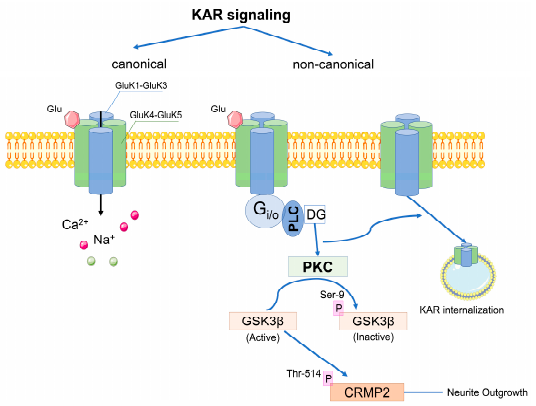
Figure 1. Canonical and non-canonical signaling of KARs (adapted from refs. [4,20] ). Postsynaptic kainate receptors are involved in synaptic transmission by mediating a small current with slow activation and deactivation kinetics. In the hippocampus, when activated by kainate or glutamate, KARs control neuronal excitability through the inhibi- tion of hyperpolarization currents, resulting in a marked increase in the firing frequency of the CA1 pyramidal cell action potentials. This activity proceeds by coupling KARs to G i/o and PKC proteins, indicating an additional metabotropic mechanism of action [5]. Kainate receptors also have the potential to affect the autoregulation of their mem- brane expression through activity-dependent internalization triggered by PKC phosphor- ylation. Furthermore, KARs are involved in the regulation of neurite growth in DG neu- rons, while the GluK2 subunit, through coexistence in a functional complex with the neu- ronal cotransporter KCC2, has an important role in the structural maturation of dendritic spines [4,32]. One of the suggested mechanisms involved in the metabotropic KAR pathway is re- lated to the NMDAR-independent regulation of LTP in the CA1-CA3 synapses. Kainate- dependent LTP recruits endosomal vesicle recycling in spines, as well as triggering their increased outgrowth and maturation. Moreover, it affects the recycling of AMPA recep- tors and enhances their surface expression in CA1 hippocampal neurons [33]. Activation of kainate receptors may also affect the presynaptic form of LTP, e.g., at thalamocortical synapses and in the cortical input of the lateral amygdala [24]. Attempts to structurally resolve the architecture of tetrameric kainate receptors have led to low-resolution structures of the GluK3 receptor in complex with kainate or the an- tagonists UBP301 and UBP310 [34,35], along with cryo-EM structures of the hetero- tetramer associated with L -Glu or the antagonist CNQX (Figure 2) [36]. This allowed the characterization of changes occurring during the activation of the kainate receptor. It be- came clear that the heteromeric subunits of GluK2 and GluK5 participate quite differently in the channel activation and desensitization process, and the main structural rearrange- ments that involve peptide linkers connecting the pore helices occur in the GluK2 subunits [34–37]. Furthermore, recently reported cryo-EM structures of the homomeric GluK2 re- ceptor in complex with one or two NETO2 subunits, in inhibited and desensitized states, revealed the molecular basis for the regulation of receptor gating and pore properties by the NETO2 protein [36].